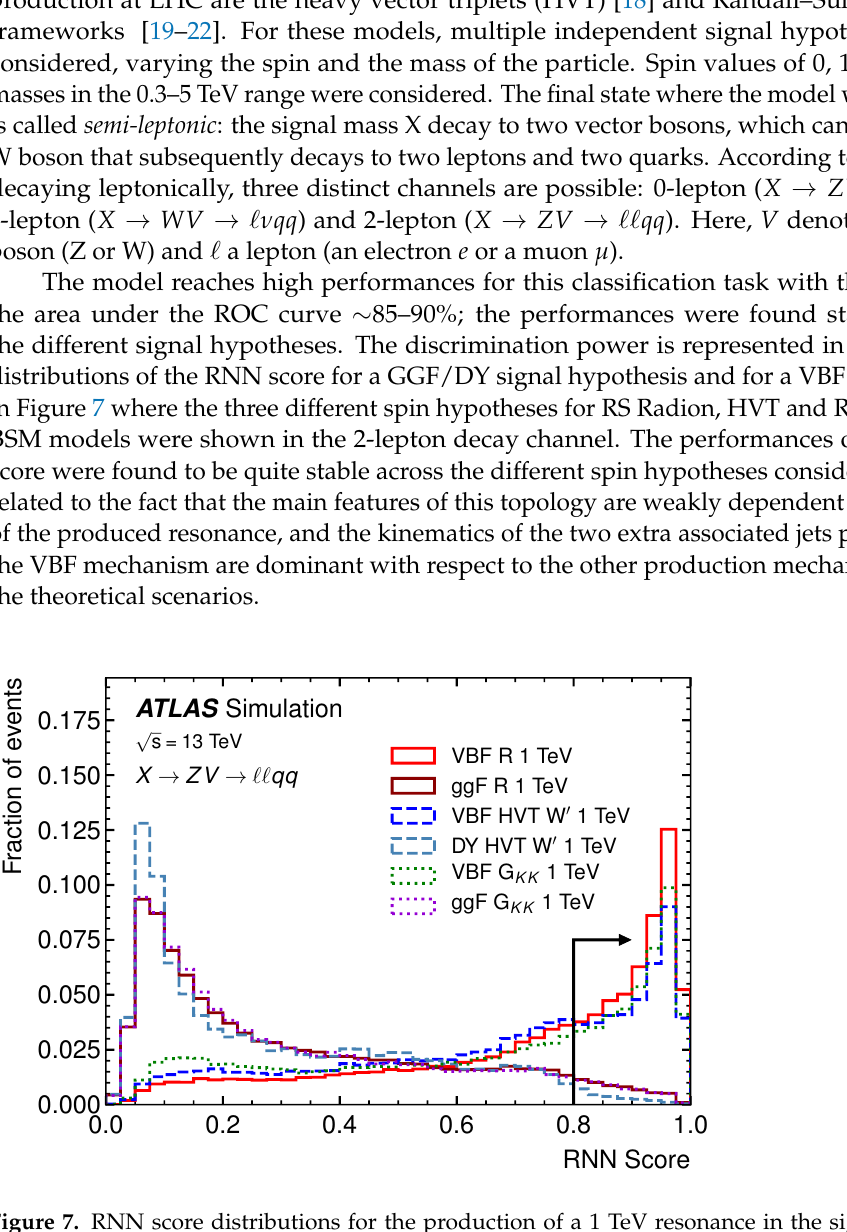
Figure 7. RNN score distributions for the production of a 1 TeV resonance in the signal models considered for this search for the 2-lepton